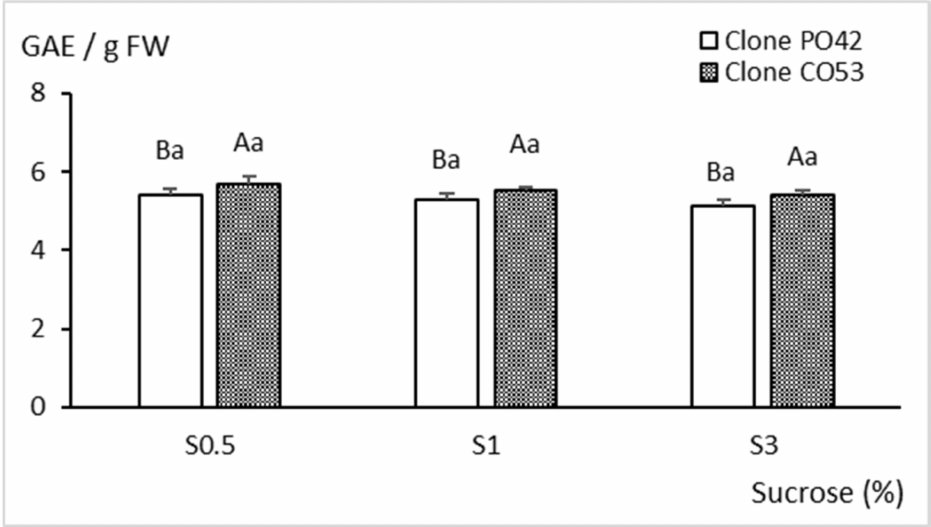
Figure 8. Effect of sucrose supplementation on soluble phenolic compounds of shoots of clones PO42 and CO53 cultured by temporary and continuous immersion, respectively. Values are the mean ± standard error from 24 shoots analyzed independently. Different capital letters indicate significant differences in relation to the genotype, and different lowercase letters indicate significant differences in relation to the sucrose supplementation ( p < 0.05). GAE: Gallic acid